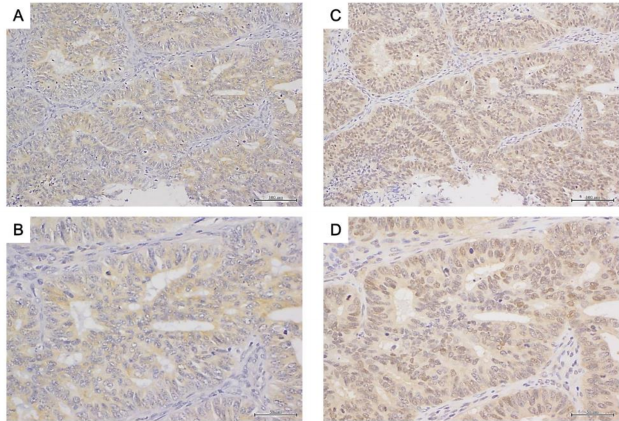
Figure 3. Immunohistochemistry for 17 β -HSD2 (endometrioid endometrial adenocarcinoma: grade 1, stage IA) (( A ) low magnification; ( B ) high magnification) and AR (endometrioid endometrial adenocarcinoma: grade 1, stage IA) (( C ) low magnification; ( D ) high magnification). Scale bar, 100 µ m ( A , C ) and 500 µ m ( B , D ).